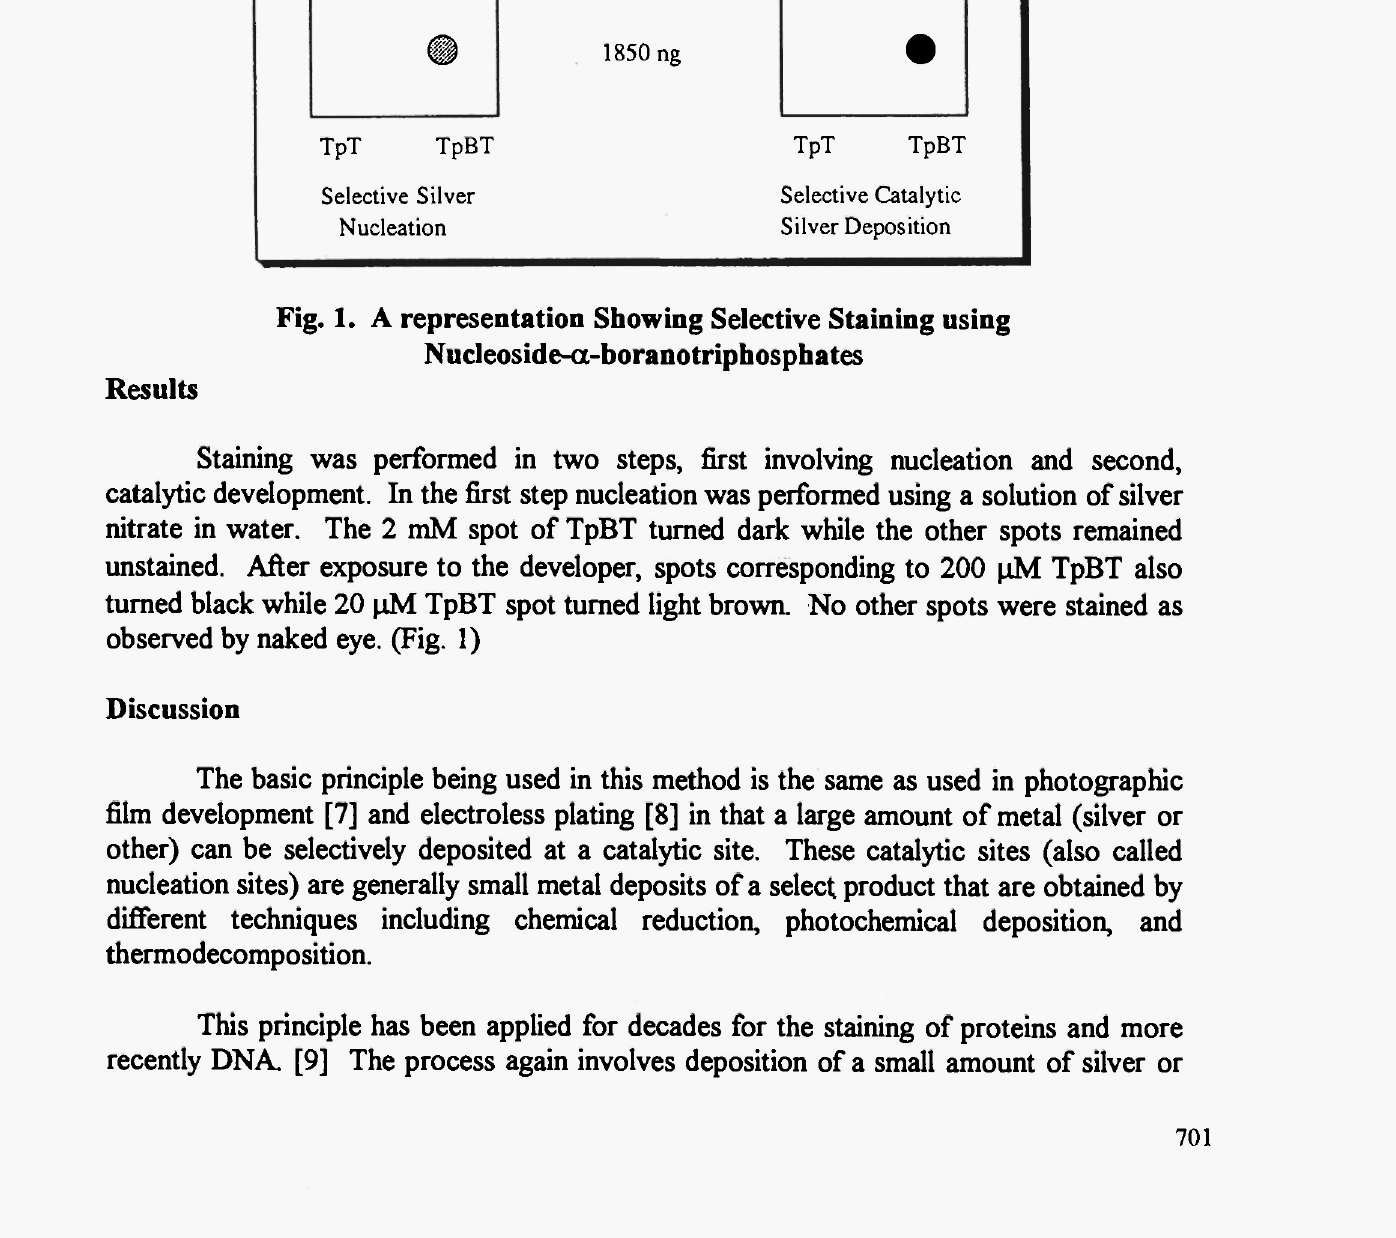
Fig. 1. A representation Showing Selective Staining